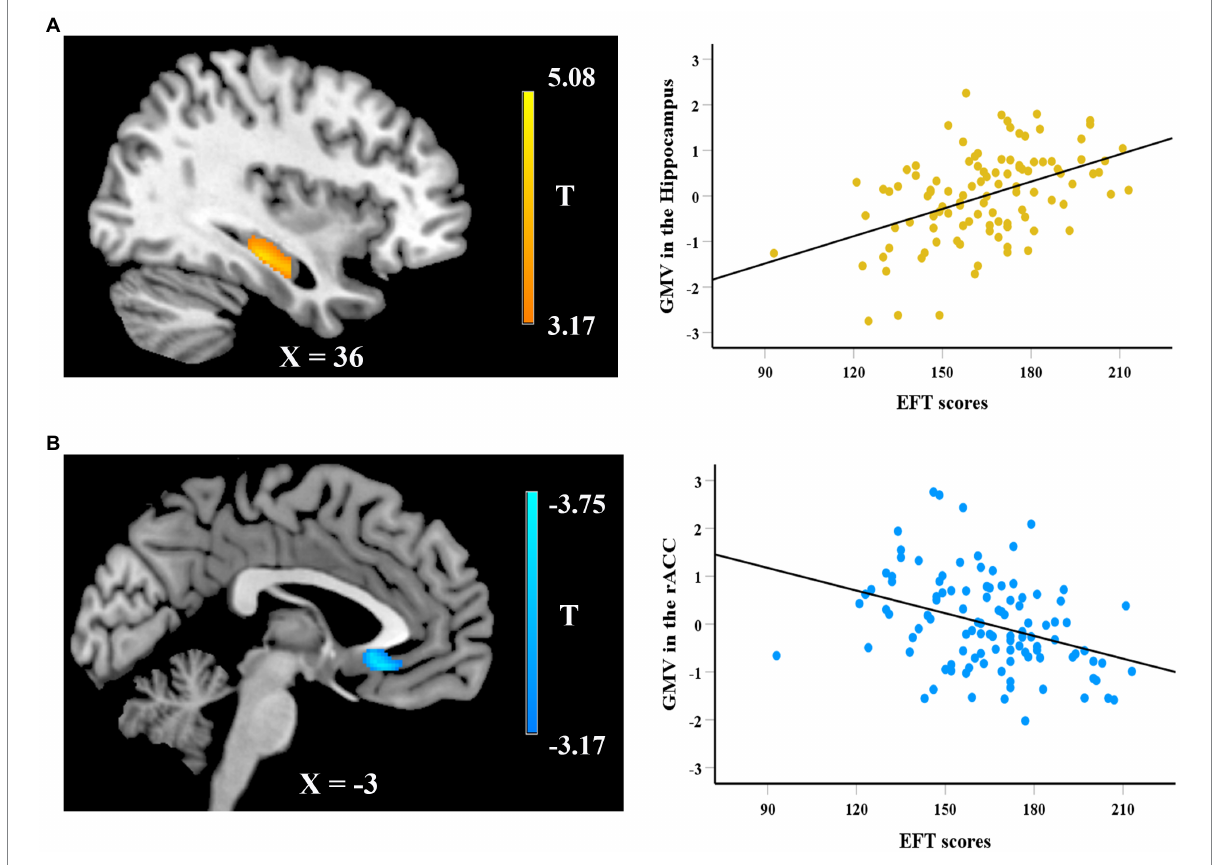
FIGURE 2 Whole-brain regression analysis showed that the gray matter volume (GMV) of a cluster in hippocampus was positively correlated with EFT scores (A) , while a cluster in rACC was negatively correlated with EFT scores (B) . Scatter plots on the right side are presented for visualization purposes only and not to be used for statistical